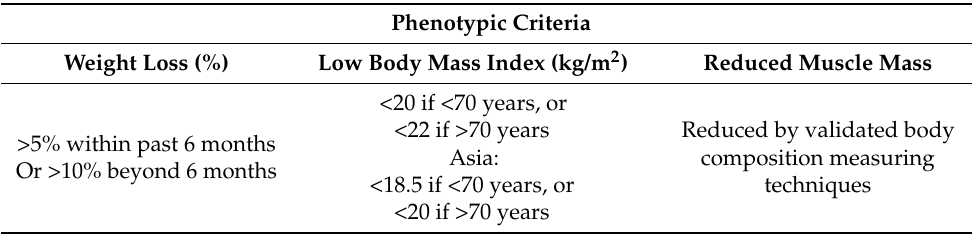
Table 1. Phenotypic Criteria for malnutrition